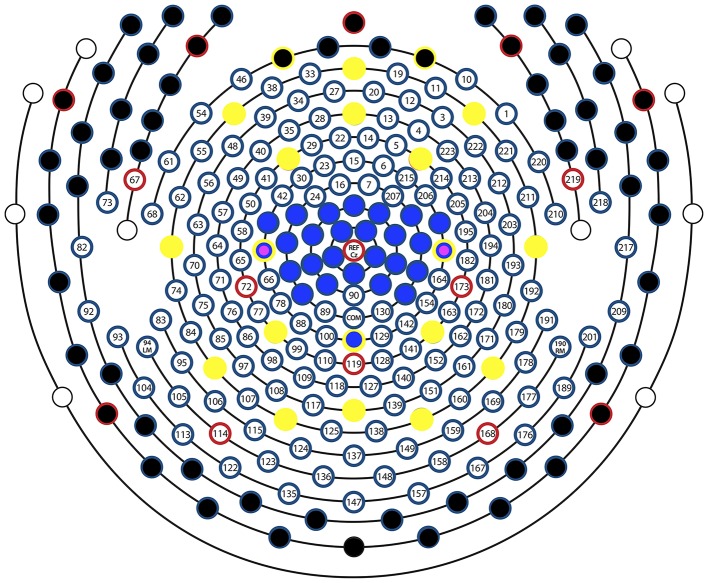
Sensor layout. Sensor layout of EGI's 256-channel sensor net, with the sensor configurations examined in this study marked with different colors. All channels except those with a black circle were used for the high-density whole brain configuration, all sensors with a blue circle were used for the high-density sensorimor configuration, all sensors with a yellow circle were used for the low-density whole brain configuration, and the two sensors with a magenta circle represent C3 and C4, used for the low-density sensorimotor configuration. Multiple overlaying colors represent channels that were used/not used in multiple configurations. E.g., Black and yellow indicates that this sensor was used in the low-density whole brain but not in the high-density whole brain configuration, while a yellow-blue-magenta circle means that the sensor was used in all 4 configurations. Red circles are retained from the original image, which is provided by EGI according to the manual. These electrodes serve as orientation points when mounting the nets. The electrode Cz was actually not used as an additional channel, but the signal from this location was included in all channels because it served as a reference.